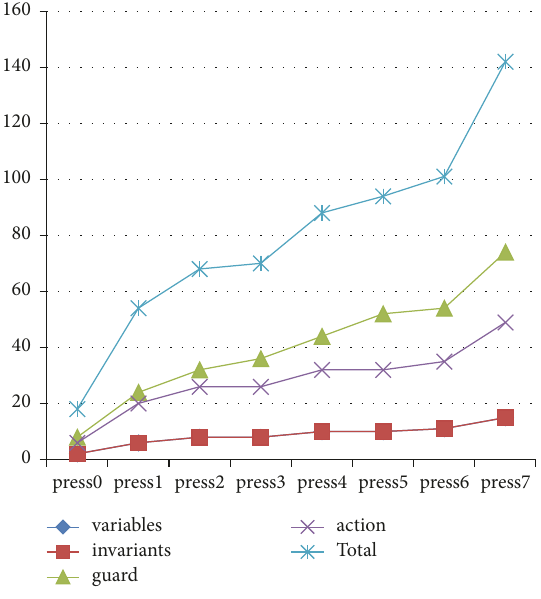
Figure 18: Statistics of Abrial’s Press